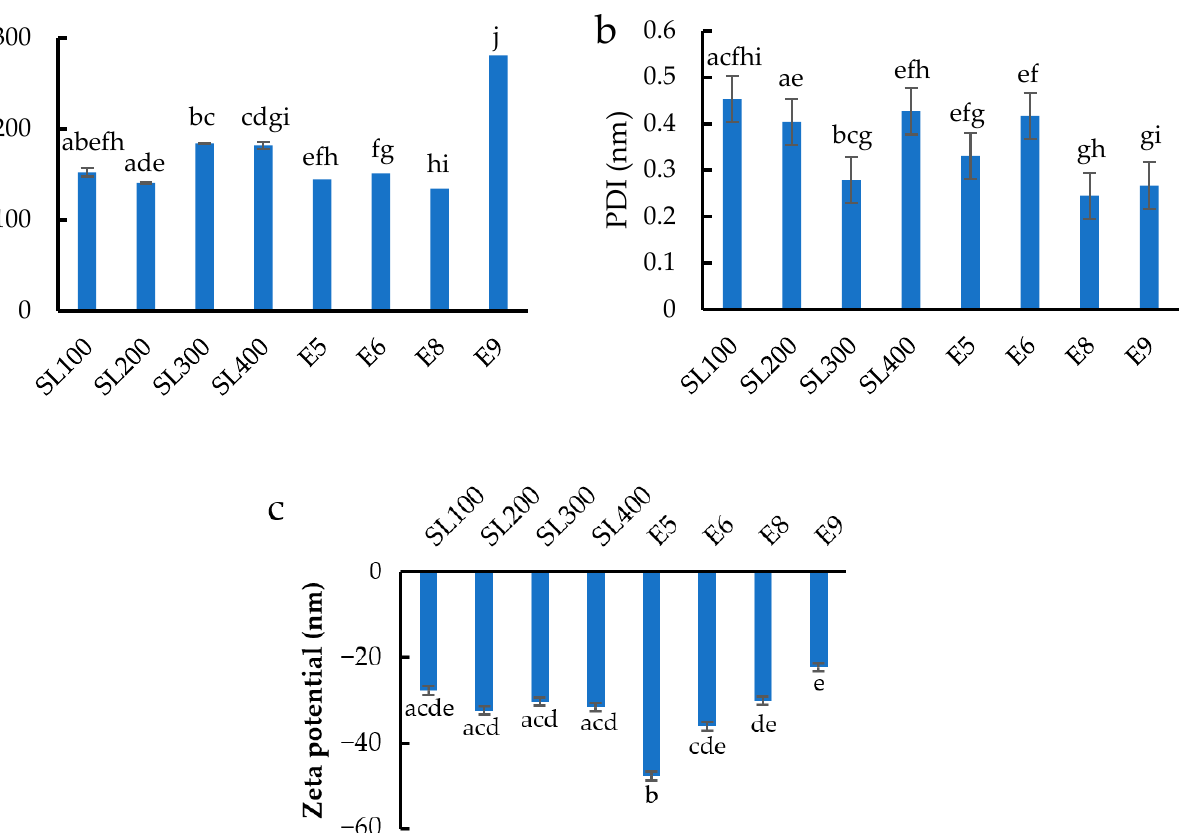
Figure 1. ( a ) Vesicle size, ( b ) size distribution, and ( c ) zeta potential of different formulations of blank ethosomes. Different letters above the error bars indicate significant differences at the 0.05 level (ANOVA and post hoc test).